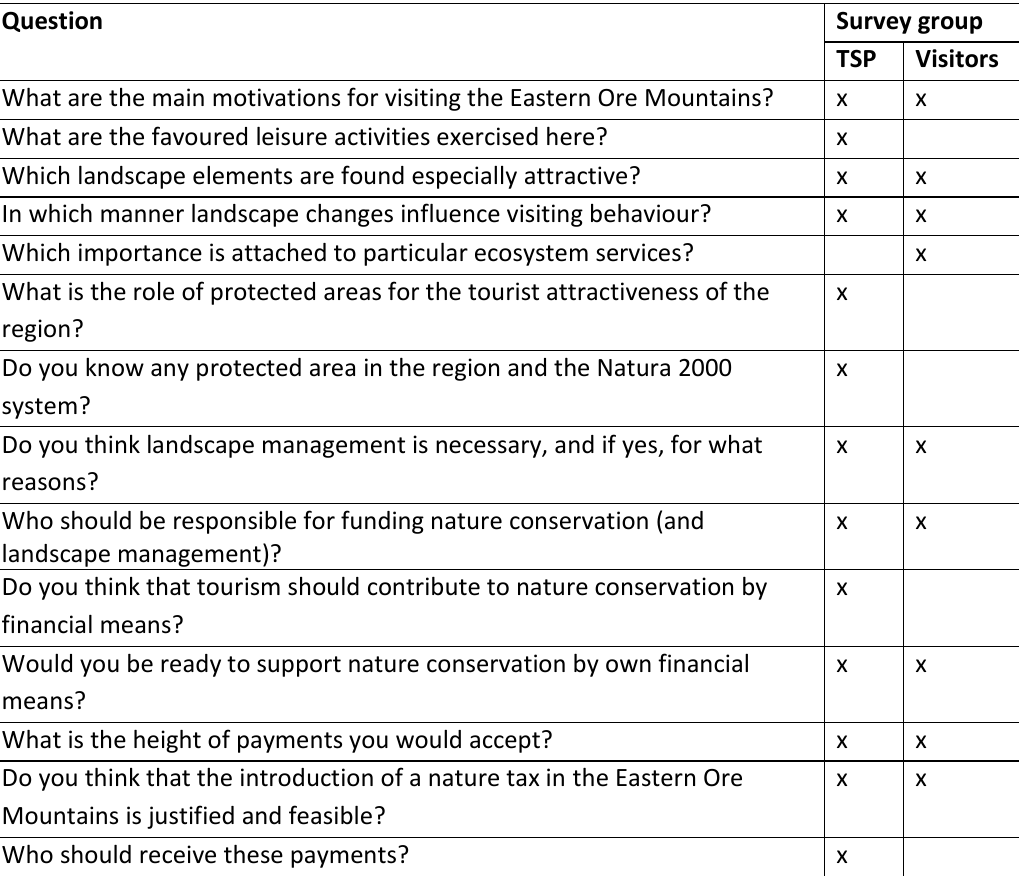
Table 1: Main content of questionnaires for the survey of tourism service providers (TSP) and visitors in the Eastern Ore Mountains